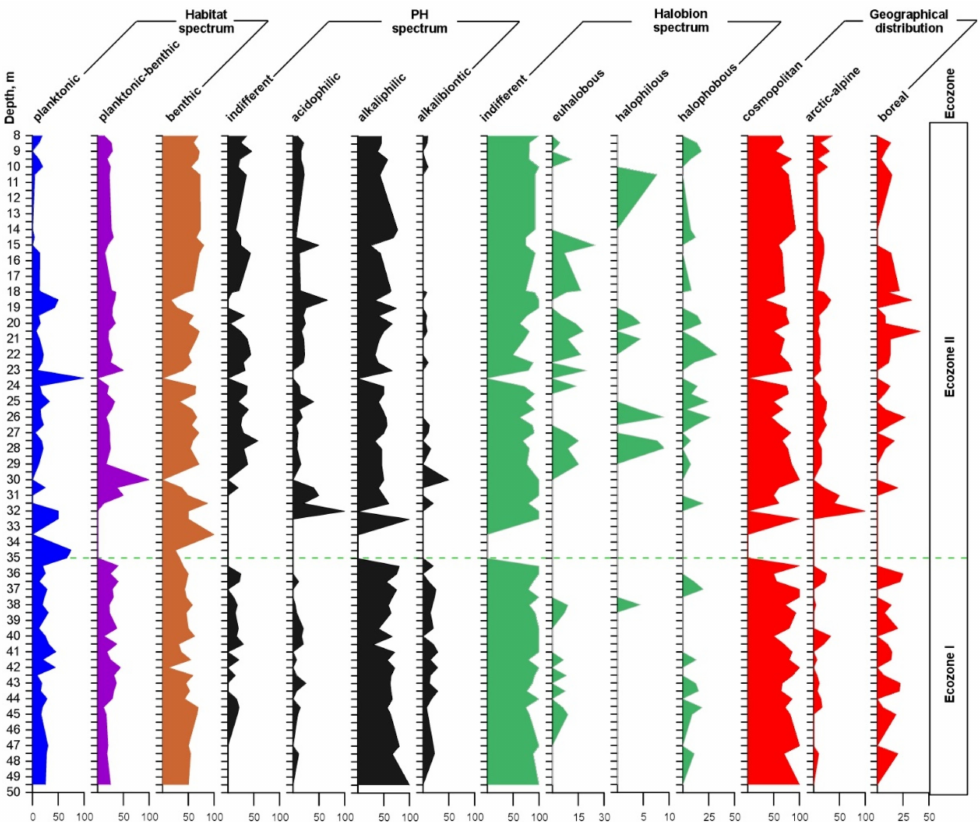
Figure 7. Different diatom ecological groups in the core Tunka-13, along the х axis (%), and along the y axis (core depth,